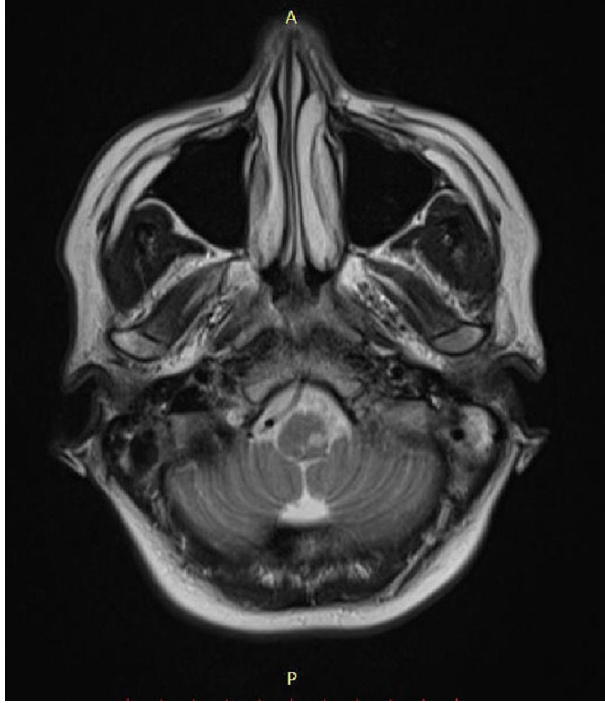
Figure 3 Axial T2-weighted magnetic resonance imaging of the brain with hyperintense signal in the posterior inferior bulb